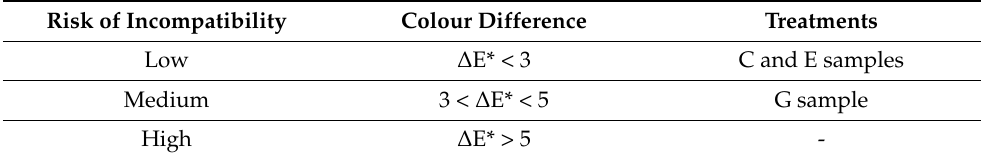
Table 11. Aesthetical compatibility of SiO 2 -based